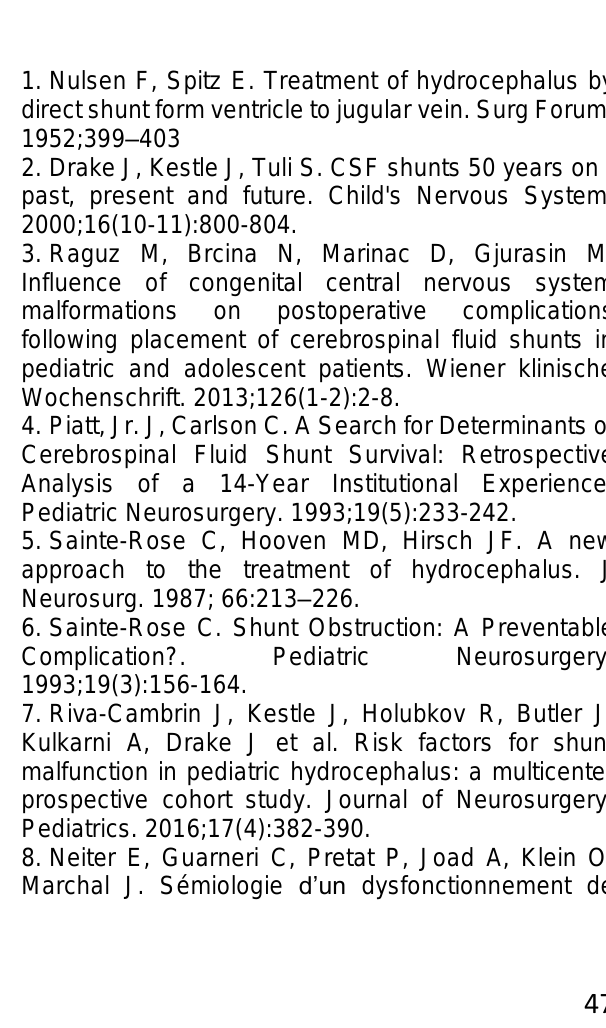
Figure 2: A. Large pneumoperitoneum in a 4-month-old infant, due to perforation of the intestine by a distal catheter. B. Surgical image of the perforation hole